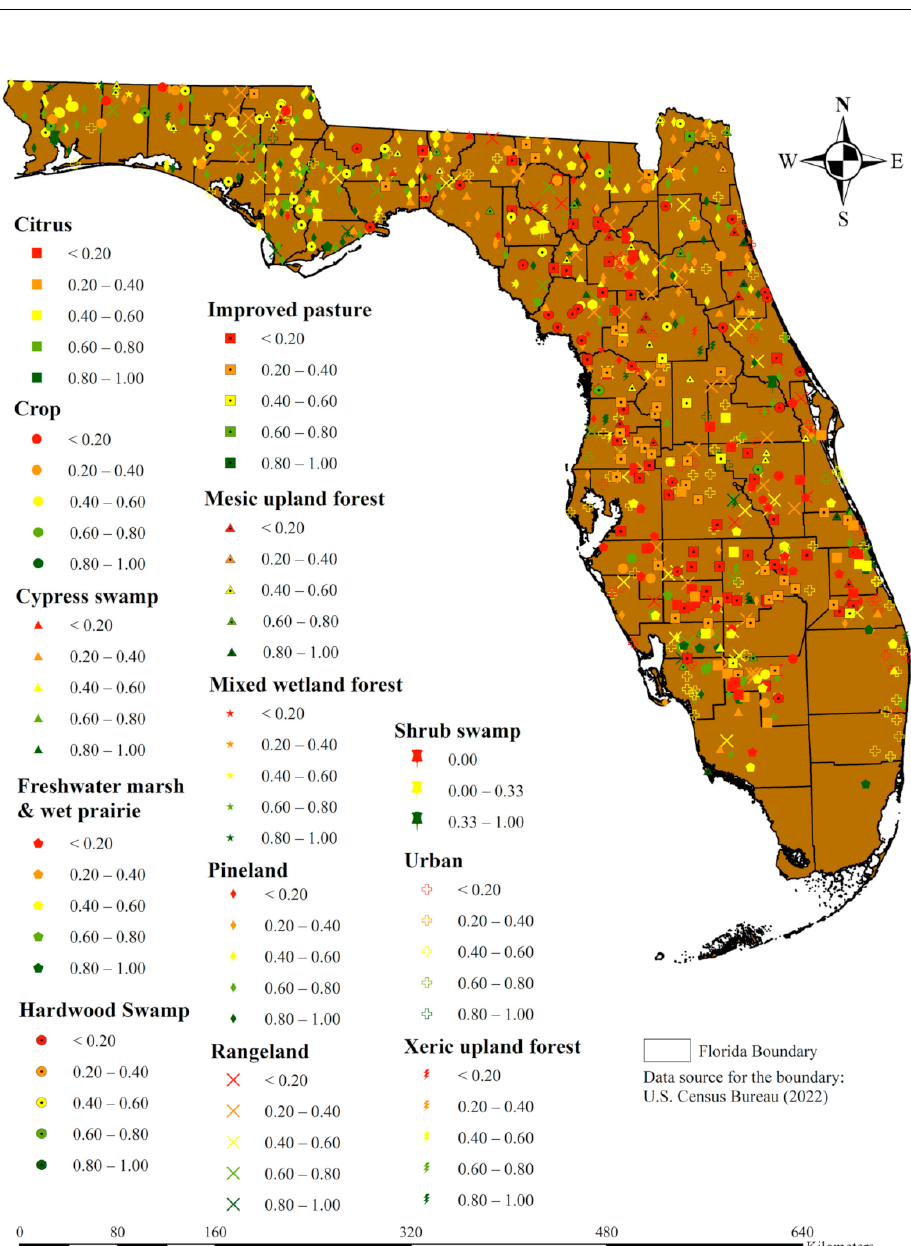
Figure 3. Data Envelopment Analysis scores for total nutrient efficiency (TNE) ensembled by the scores with a free-disposable hull, variable returns-to-scale, and constant returns-to-scale. Note that the red, yellow, and green colors of each symbol indicate the low/medium/high efficiencies,